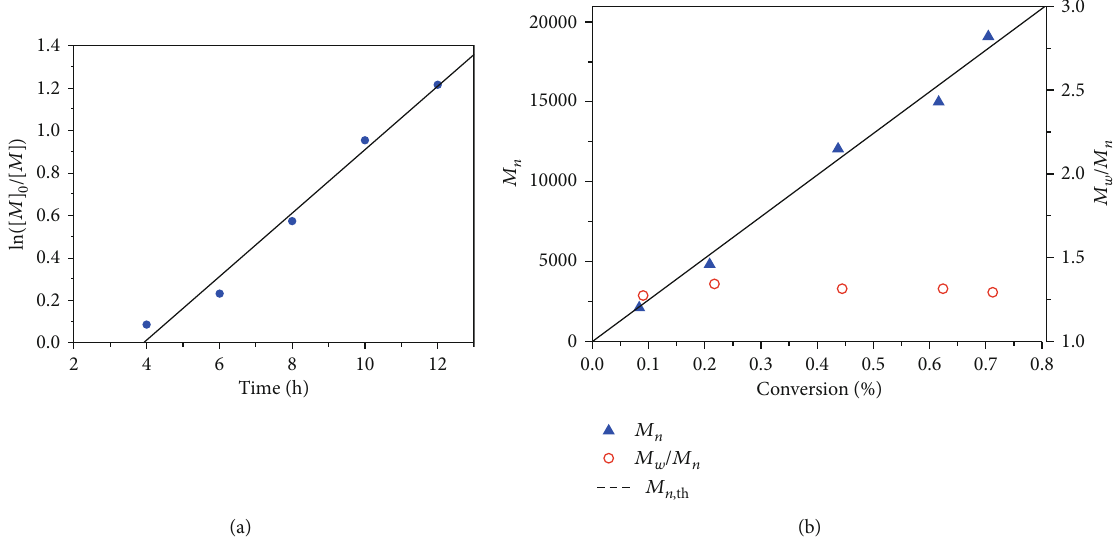
Figure 1: (a) ln ð½ M (cid:2) / ½ M (cid:2)Þ as a function of time for the RAFT copolymerization of St and MAh initiated by Asc. (b) Number-average 0 molecular weight ( M n ) and molecular weight distributions ( M w / M n ) versus conversion for the RAFT copolymerization of St and MAh initiated by Asc. Polymerization conditions: ½ St (cid:2) / ½ MAh (cid:2) / ½ DDMAT (cid:2) / ½ Asc (cid:2) = 148/148/1/1 ð½ DDMAT (cid:2) = 0 : 1 mmol Þ , DO/monomer = 1/1 ð w / w Þ , T = 25 ° C .